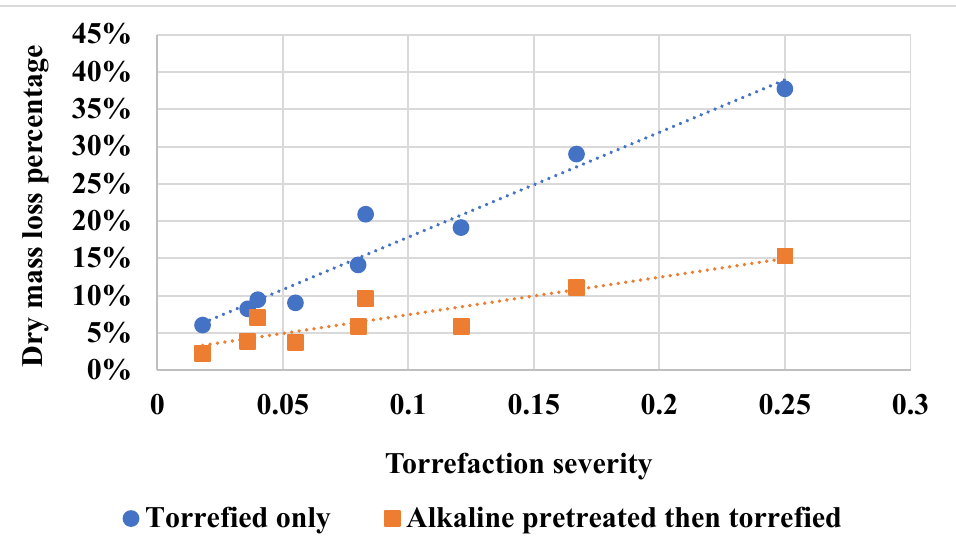
Figure 1. Dry mass loss of wheat straw due to torrefaction.